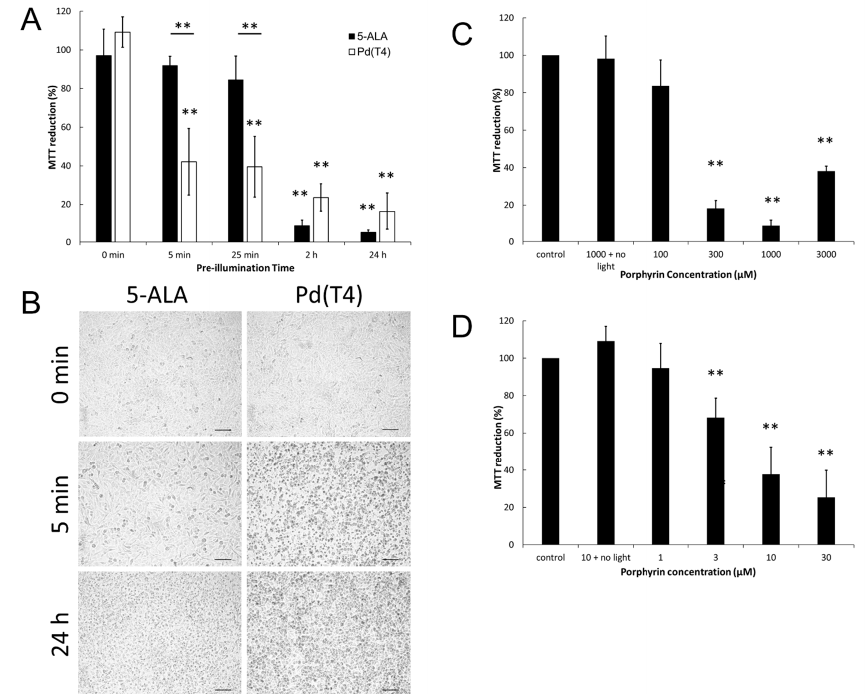
Figure 2. E ff ects of pre-illumination time and photosensitizer concentrations on oncolytic activity. C918 melanoma cells were grown to 90–100% confluency, then incubated with porphyrin 5-aminolevulinic acid (5-ALA) (1 mM) or Pd(T4) (10 µ M) at various times with subsequent exposure to 60 mW of 405 nm light for 88 s (5 J / cm 2 ) or without light (0 s). ( A ) Dark bars represent 5-ALA (1 mM) and open bars Pd(T4) (10 µ M). Percent 3-(4,5-dimethylthiazol-2-yl)-2,5-diphenyltetrazolium bromide (MTT) reduction was determined by dividing the absorbance value from a MTT assay of the treatment group by cells alone and multiplied by 100. Data represents average ± standard deviation of duplicate wells from three to five independent experiments. ( B ) Morphological changes of cells after 24 h post-irradiance comparing the e ff ect of photosensitizer pre-incubation at 5 min or 24 h with and without (0 s) 5 J / cm 2 of 405 nm irradiance. Scale bar represents 100 µ m. Cells were incubated with di ff erent concentrations of photosensitizers: 5-ALA ( C ) or Pd(T4) ( D ) for 2 h before irradiance with 5 J / cm 2 of 405 nm light. Cell viability was tested post-photodynamic therapy (PDT) using a MTT assay analyzing the percent MTT reduction by dividing the absorbance of the treatment group against cells alone multiplied by 100. Data represents average + standard deviation of duplicate wells from three to five independent experiments. Statistical di ff erences between the absence and presence of light treatments ( A ), between treatment groups at similar time points ( A ), and against di ff erent concentrations of porphyrins ( C , D ) were analyzed using one-way analysis of variance (ANOVA) with Tukey’s multiple comparison test. Note: ** p <